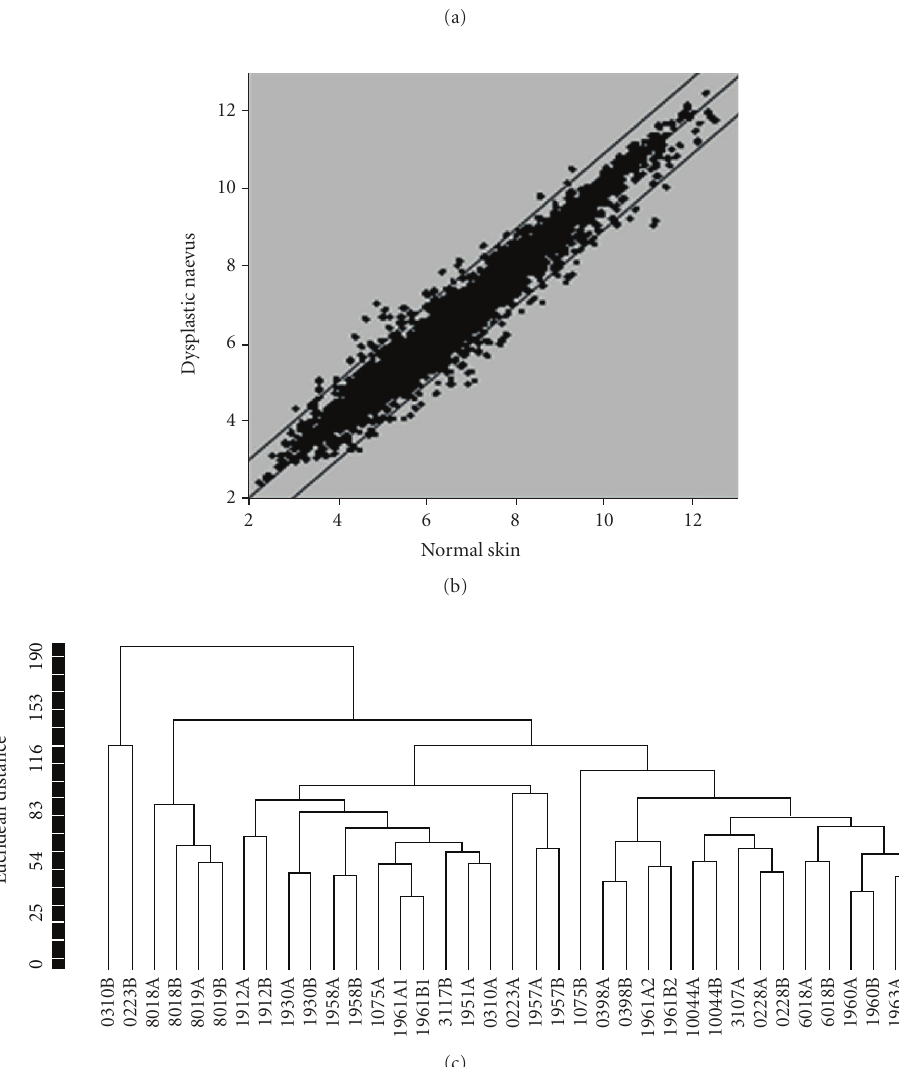
Figure 1: (a) Photos (4x magnification) taken from cultures of melanocytes derived from normal skin (left, MC) and dysplastic naevus (right, DNMC), representative of the MC and DNMC cultures of all 18 patients from which each of the melanocyte cultures were derived. (b) Scatter plot with average-log expression ratio’s within one DNMC sample plotted against the average-log ratio’s within the paired MC sample from one representative patient sample set. Each dot represents an interrogated probeset. The diagonal lines in the graph are outlier lines that indicate a 2-fold di ff erence in the geometric mean of the expression ratio’s between the DNMC and MC sample. (c) Clustering dendrogram of the expression values of all melanocyte samples. The vertical axis indicates the Euclidean distance with complete linkage as a measure for the extent of similarity between the samples. The horizontal axis contains all samples; A-labeled sample numbers, melanocytes derived from normal skin; B-labeled sample numbers, melanocytes derived from dysplastic naevus. The calculated R -index (0.997) and D -index (0.02) showed that the clusters were highly